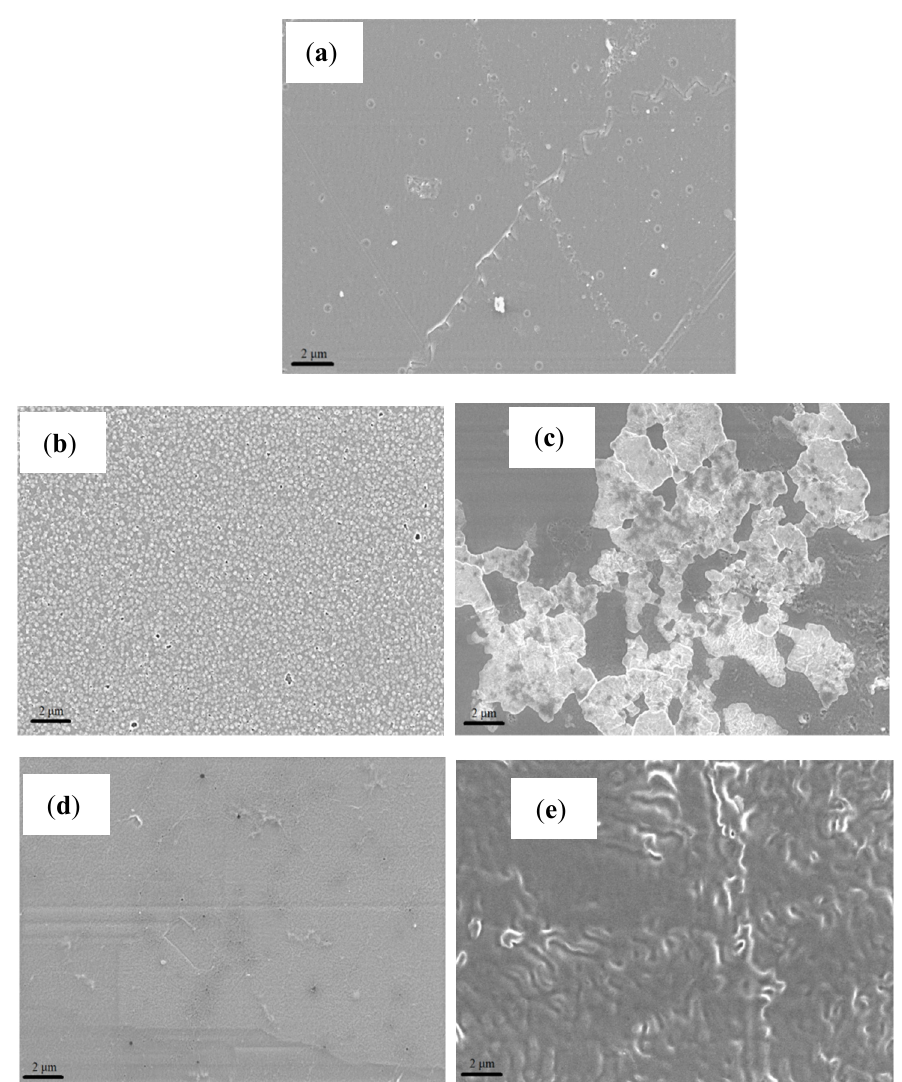
Figure 2. SEM image of the PEM at magnification of 5 kX ( a ) recast Nafion ® , ( b ) Nafion ® /2-HEAF (40 wt.%), ( c ) Nafion ® /2-HEAF (70 wt.%), ( d ) Nafion ® /PAN (40 wt.%) and ( e ) Nafion ® /PAN (70 wt.%).